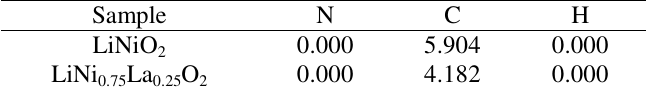
Table 2. Analysis of impurity elements in the products Sample